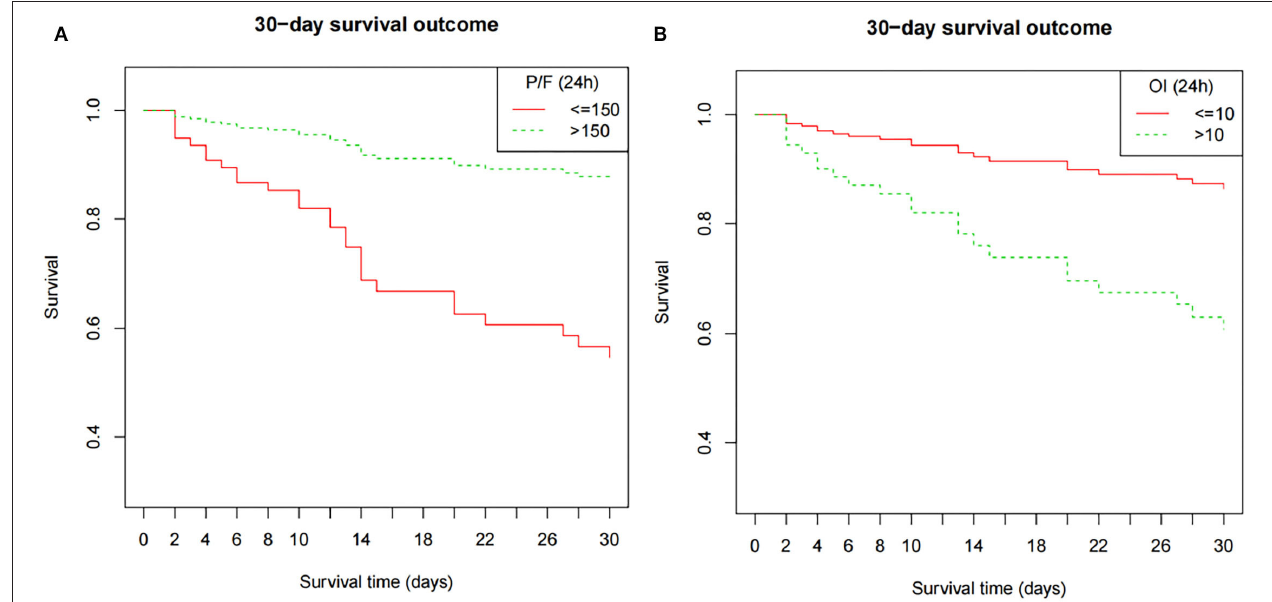
FIGURE 3 | The Kaplan–Meier survival curve as a function of the oxygenation status at 24h, using dichotomized indices: OI ≥ 10 and < 10; P/F ratio > 150 and ≤ 150). The survival results significantly differed between the groups (OI, P = 0.047; P/F ratio, P = 0.026). The model is adjusted for age, septicemia, CRRT, PIP (24h), and Lac (24h). P/F, PaO 2 /FiO 2 ; OI, oxygenation index; MAP, mean airway pressure; PIP, peak inspiratory pressure; Lac, lactate; CRRT, continuous renal replacement